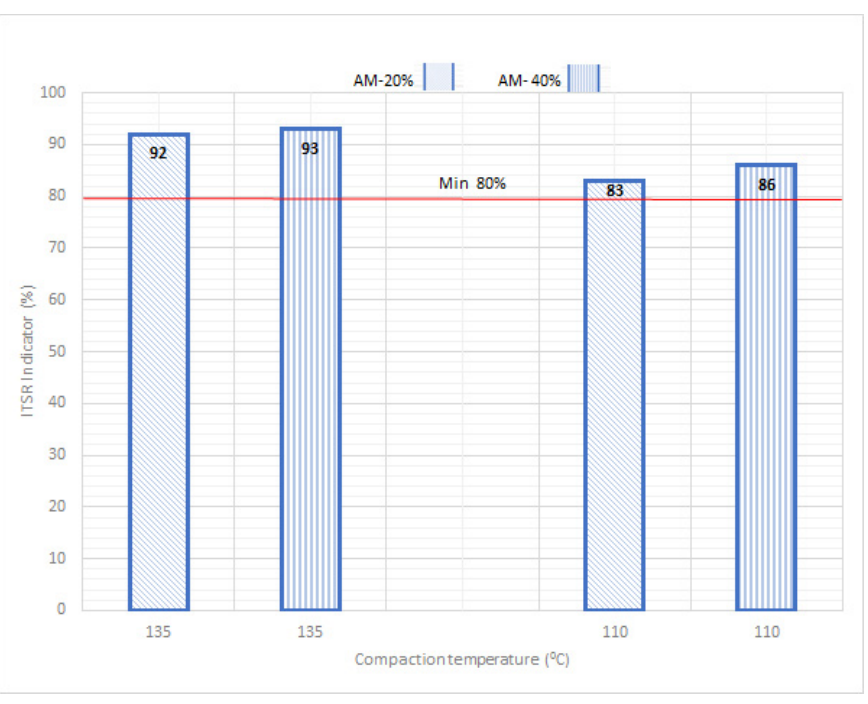
Figure 4. ITSR results for AM-20% and AM-40%.